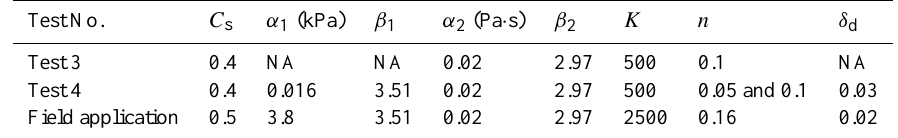
Table 2. Hydrological parameters for simulating the erosion and deposition processes in Test 3, Test 4 and field application. Test No. C s α 1 (kPa)